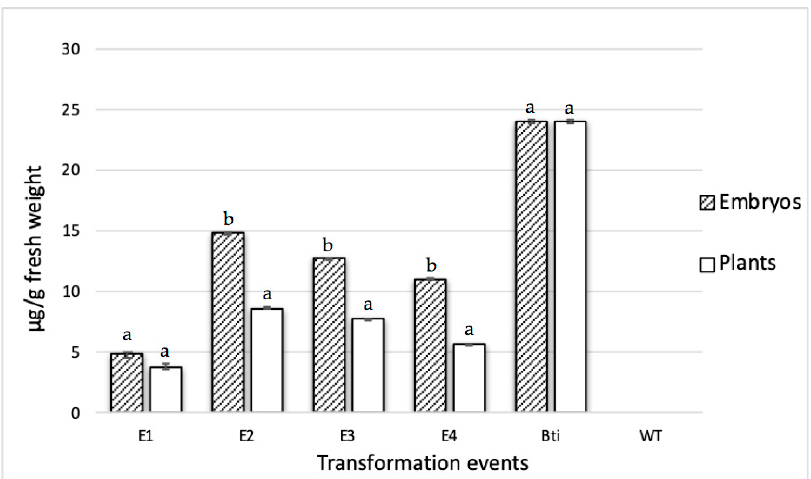
Figure 5. Cry10Aa protein immunodetection in transformed and wild-type coffee plants by ELISA. The primary antibody used in all experiments was the polyclonal anti-Cry10Aa. Total protein per well, 10 µ g. Letters represent statistical significance (Student’s t -test) between embryos and leaves from each transformation